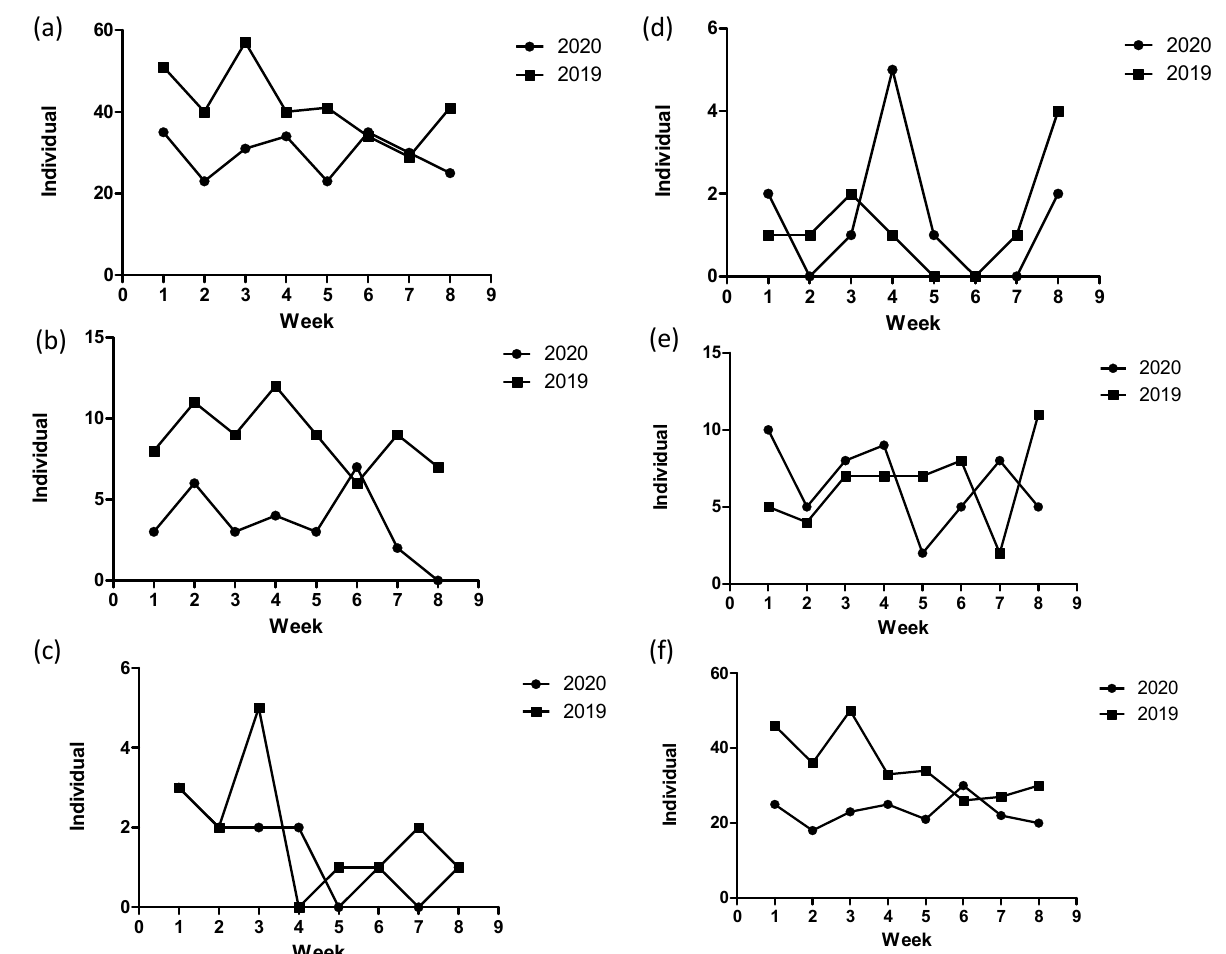
Figure 2. Weekly number of patients receiving the ( a ) total types of surgery, ( b ) total knee arthroplasty, ( c ) total hip arthroplasty, ( d ) hemiarthroplasty, ( e ) emergency surgery, and ( f ) elective surgery at the community hospital during the study (2020) and control (2019) periods.